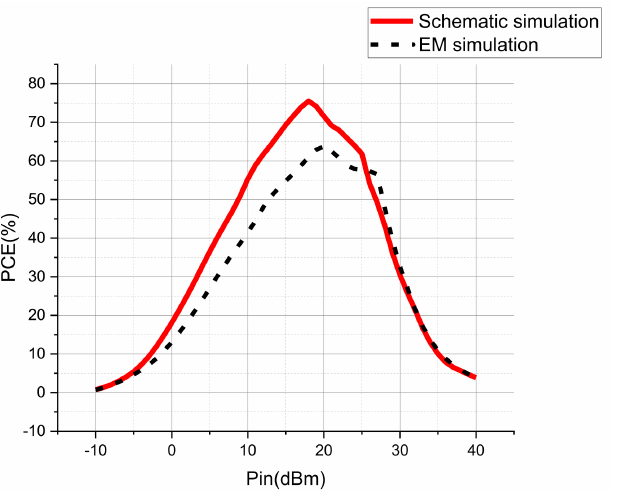
Figure 11. Transmission efficiency comparison of the single/dual RF-DC microwave rectifier